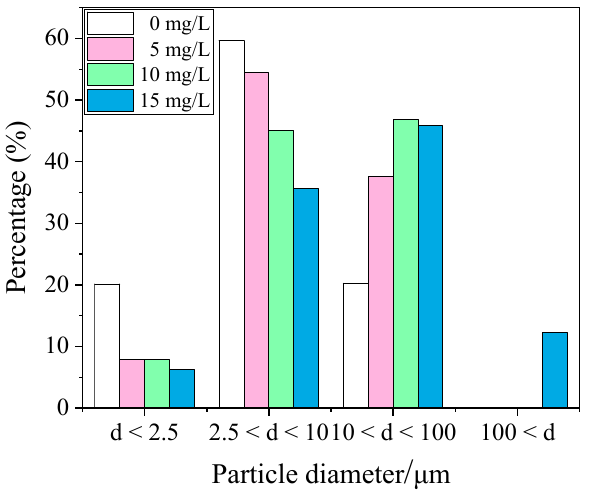
Figure 7. Histogram of particle size interval content of coagulant